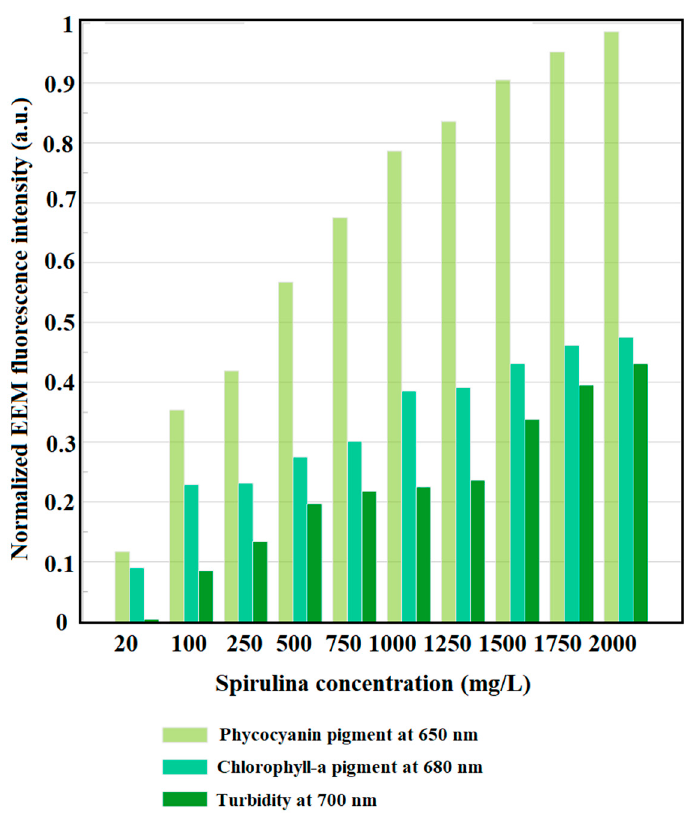
Figure 5. Normalized values of the pigments at varying commercialized AZTEC Spirulina concentration.